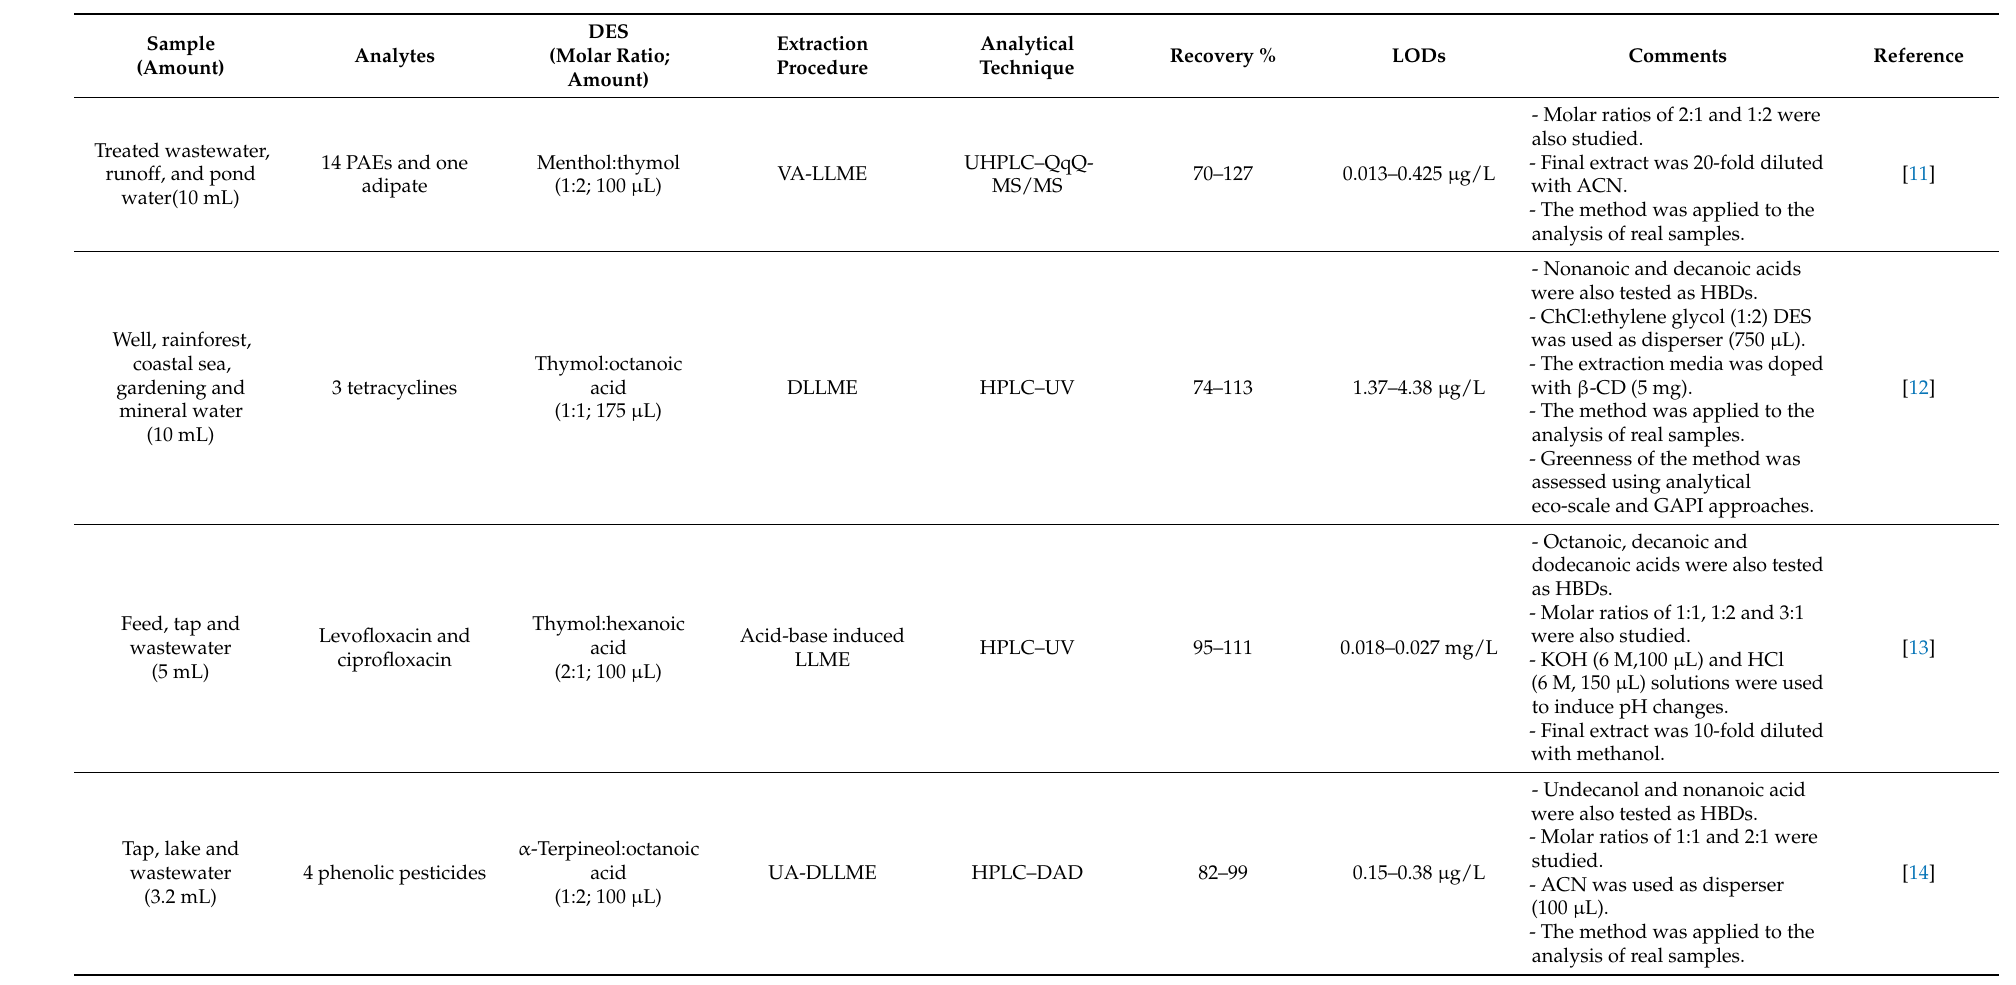
Table 1. Some examples of the recent applications of DESs to the analysis of organic compounds in environmental